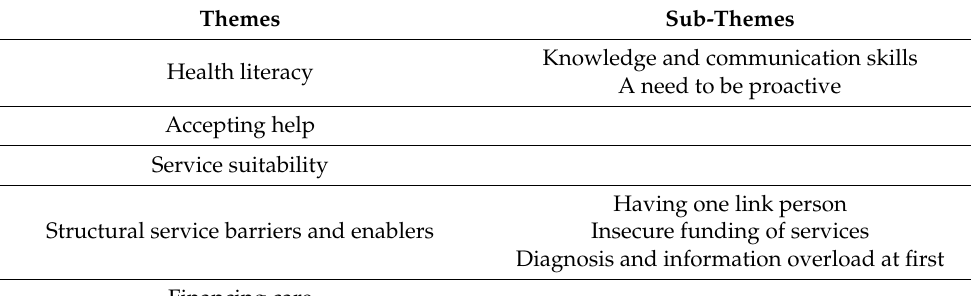
Table 3. List of themes and